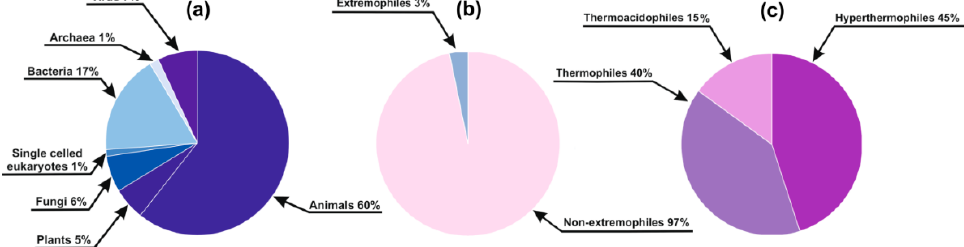
Figure 1. Species distribution of the DisProt Database: ( a ) Distribution of DisProt entries among large phylogenetic groups; ( b ) Distribution of the represented species among extremophiles and non-extremophiles; ( c ) Distribution of the 20 extremophilic proteins among different lifestyle extremities.